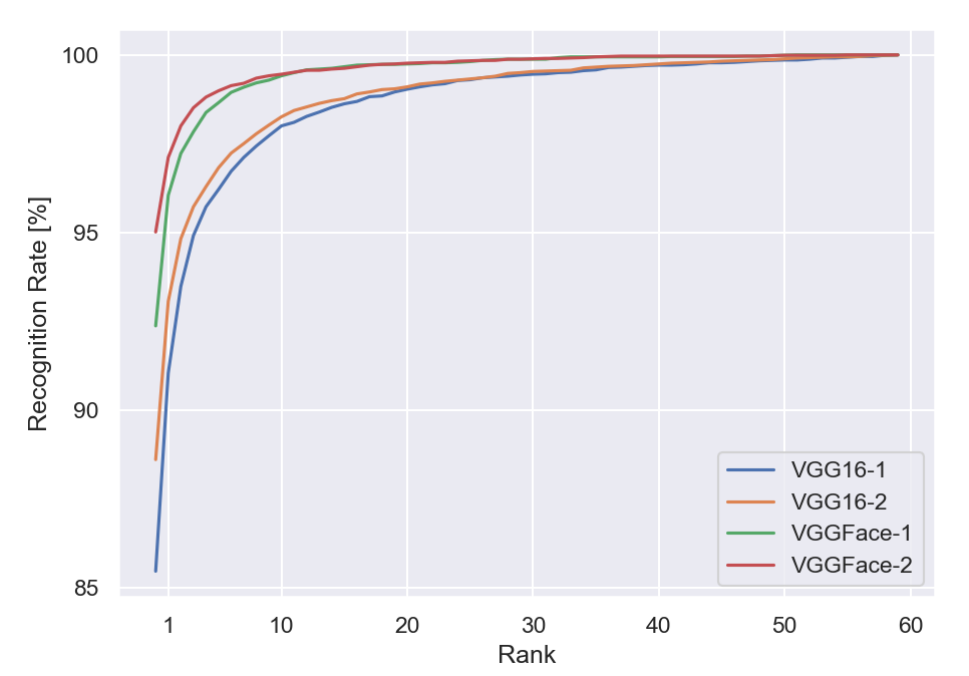
Figure 9. CMC curves for the test set of the VGGFace-Ear dataset.